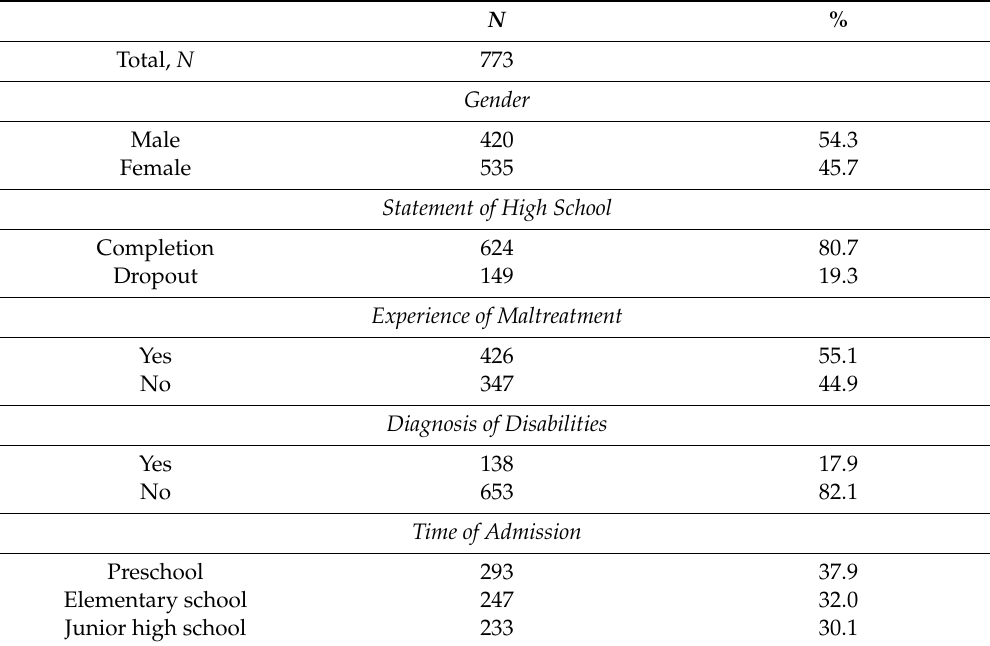
Table 1. Description of youth in this study.